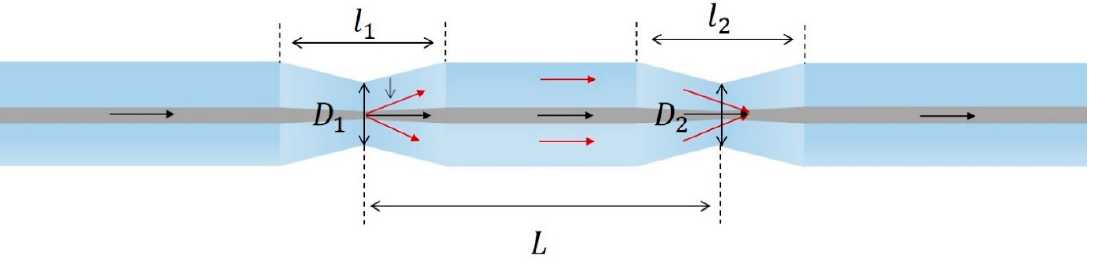
Figure 1. Schematic diagram of the micro taper in-line fiber Mach–Zehnder interferometer (MZI).